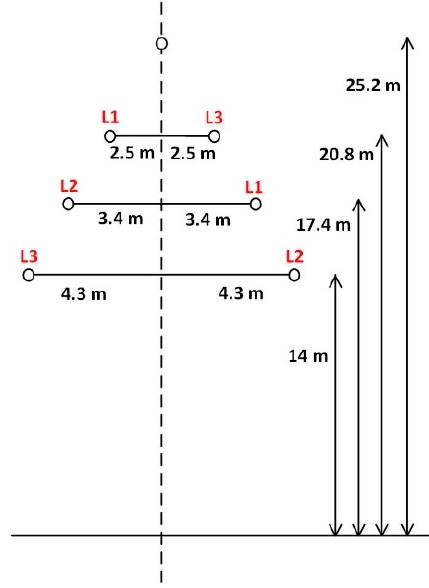
Figure 6. Transmission line conductor arrangement. Table 1. Line parameters .